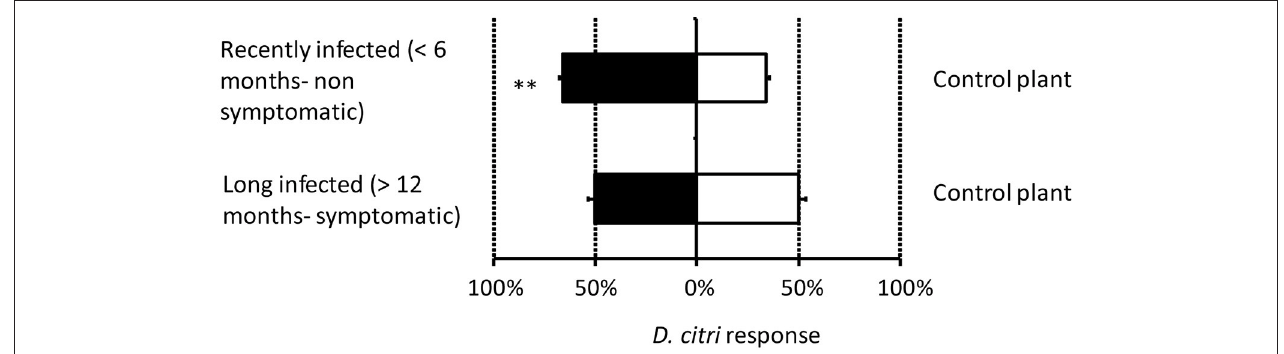
FIGURE 3 | Response of Diaphorina citri females to odors from citrus plants recently infected by Candidatus Liberibacter asiaticus ( < 6 months), or infected for a longer period ( > 12 months) vs. the odor from uninfected citrus within a T-maze olfactometer. Asterisks indicate significant differences between the two treatments (* P < 0.05).